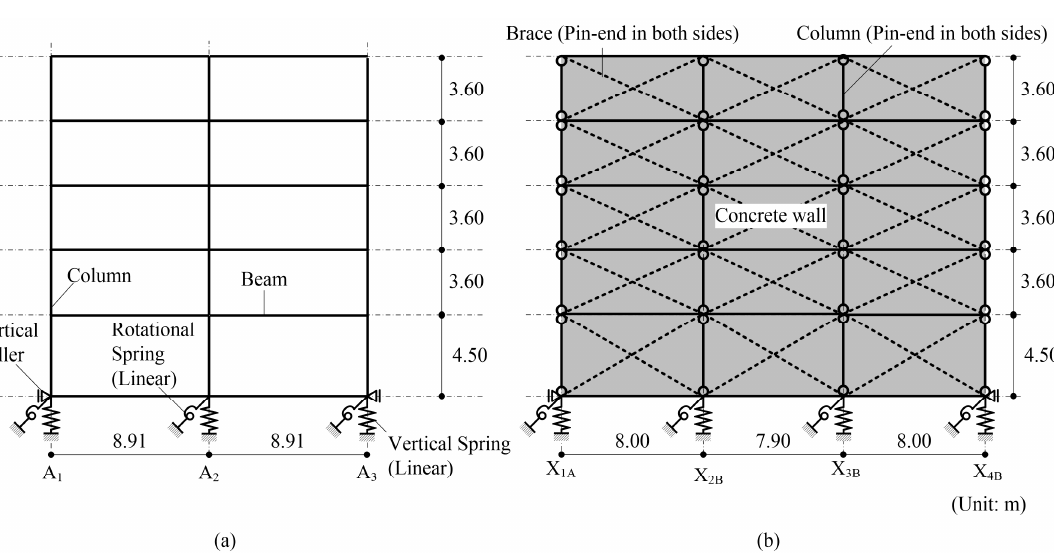
Figure 9. Model of each frame: ( a ) frame B 1 and ( b ) frame Y 5 .